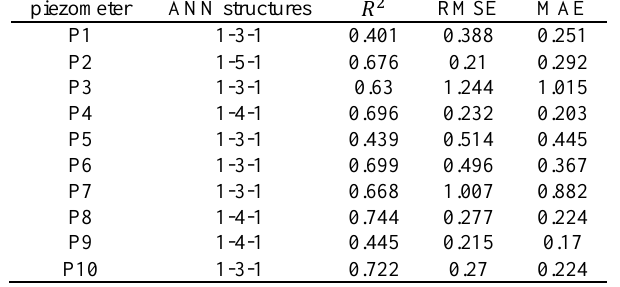
Table 6 . 𝑅 2 , MAE and RMSE values in GWL prediction by ANN models in a testing period. piezometer ANN structures 𝑅 2